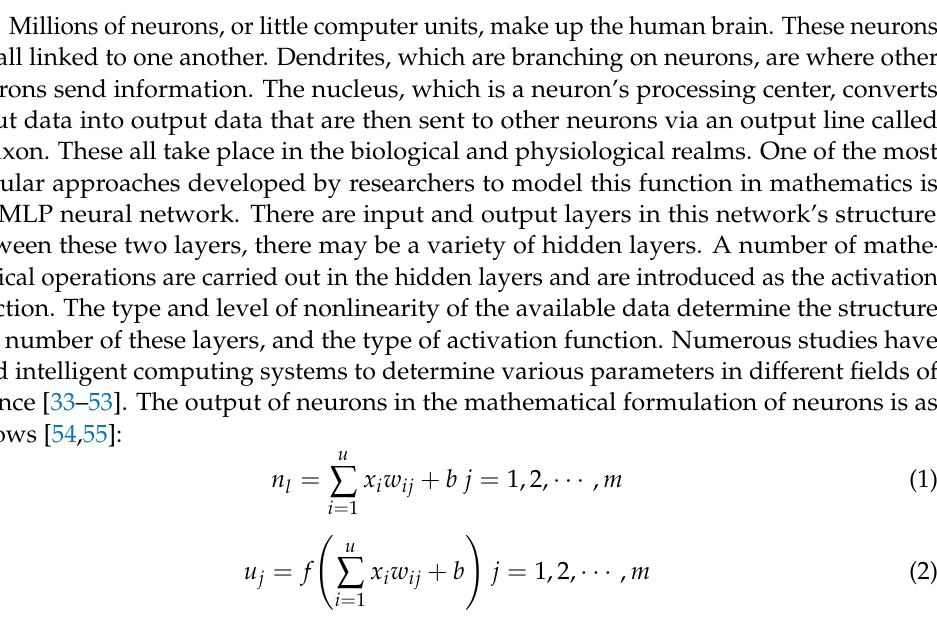
Figure 4. Extracted characteristics in terms of scale thickness in constant volume percentage (10% gas, 40% oil, and 50% water).